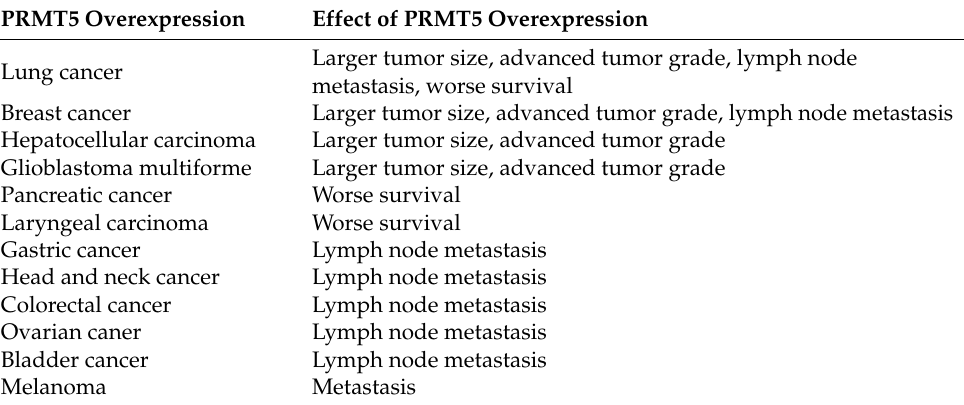
Table 1. The role of PRMT5 overexpression in